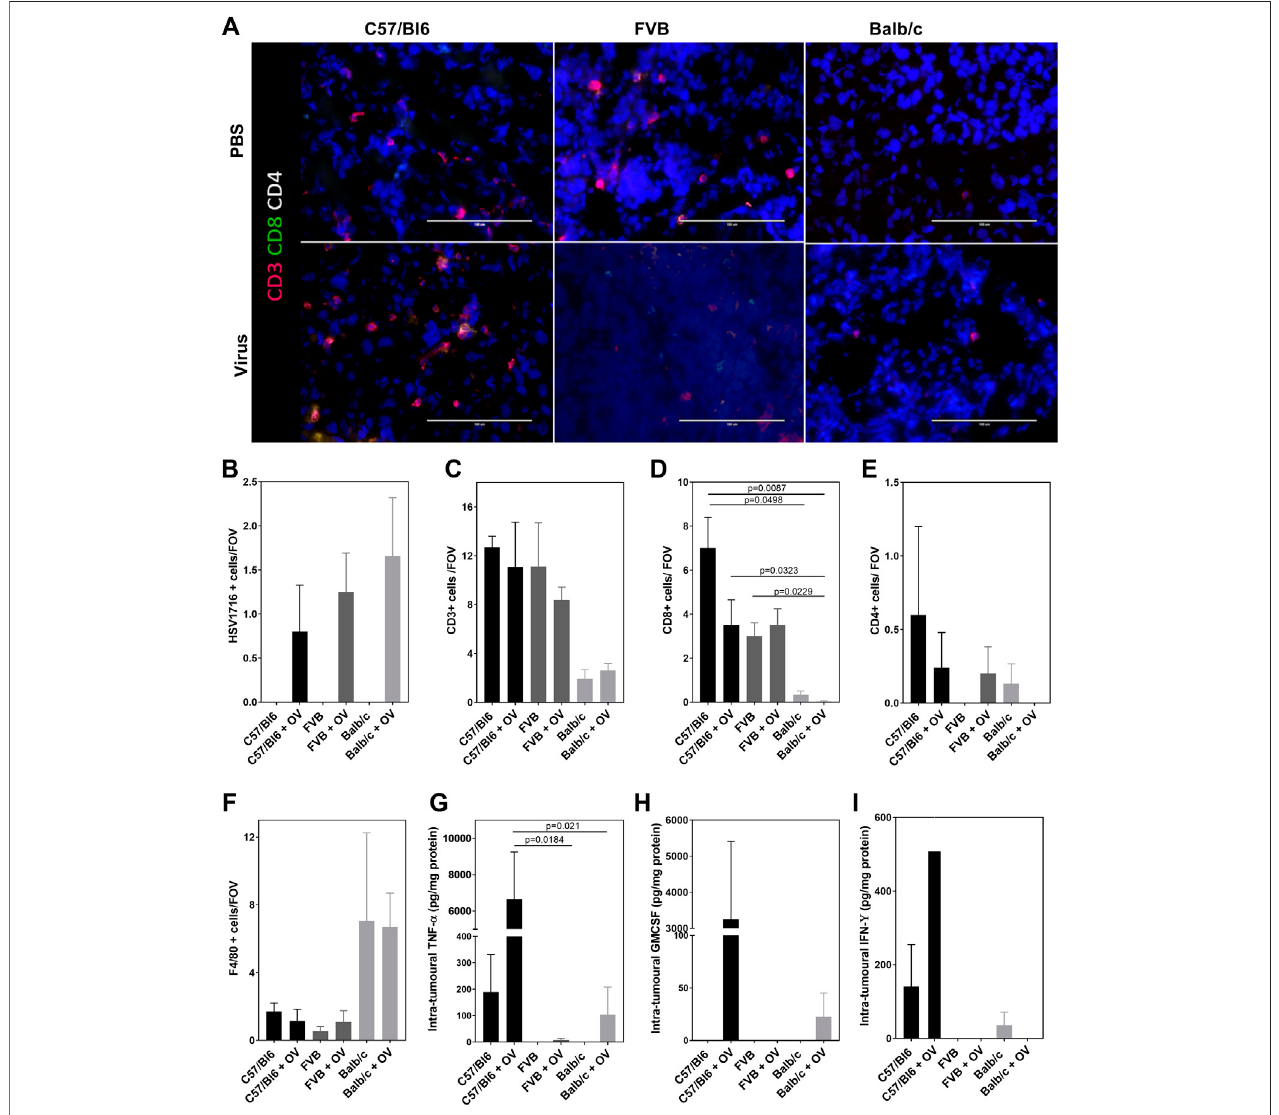
FIGURE 2 | Model dependent T-cell activation. Representative images of tumor sections examined by terminal immuno fl uorescence staining (A) and their quanti fi cationofsignalsforHSV1716+cells (B), CD3 + Tcells (C) ,CD8 + Tcells (D) ,CD4 + Tcells (E) ,andF4/80+macrophages (F) .IntratumoralconcentrationsofTNF- α (G) ,GM-CSF (H) ,andIFN- ϒ (I) weredetectableusingtheCBAassay.Dataareshownasmean±SD.Statisticalsigni fi cancewasdeterminedbyone-wayANOVAwitha Tukey post hoc